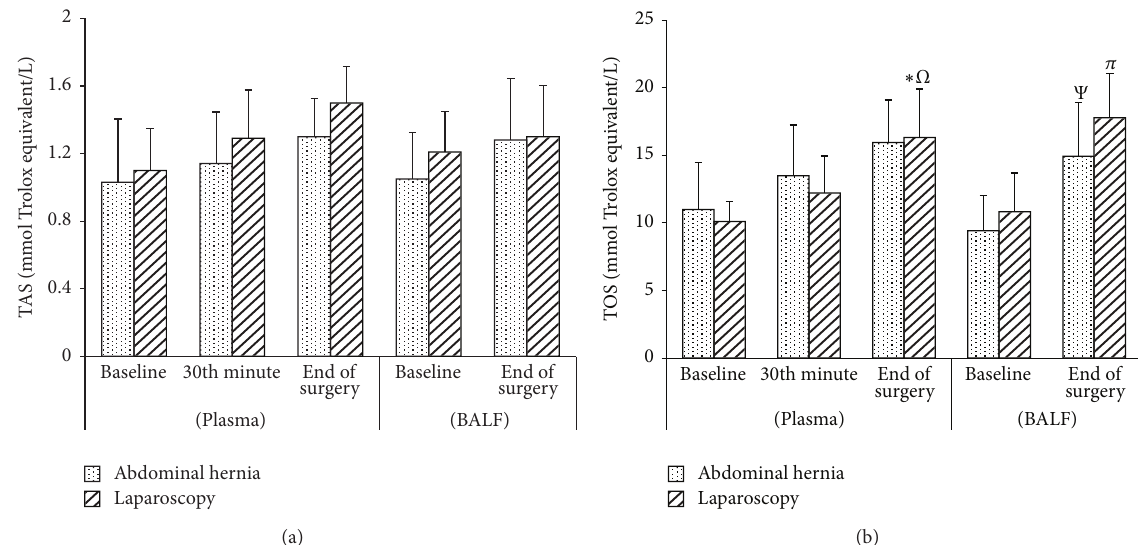
Figure 1: Pre- and perioperative TAS (total antioxidant status) (a) and TOS (total oxidant status) (b) levels of the groups in plasma and BALF. Data are expressed as mean ± standard error. ∗ 𝑃 < 0.001 compared to plasma baseline, Ω 𝑃 < 0.05 compared to 30th minute, Ψ 𝑃 < 0.05 compared to BALF baseline, 𝜋 𝑃 < 0.05 compared to BALF